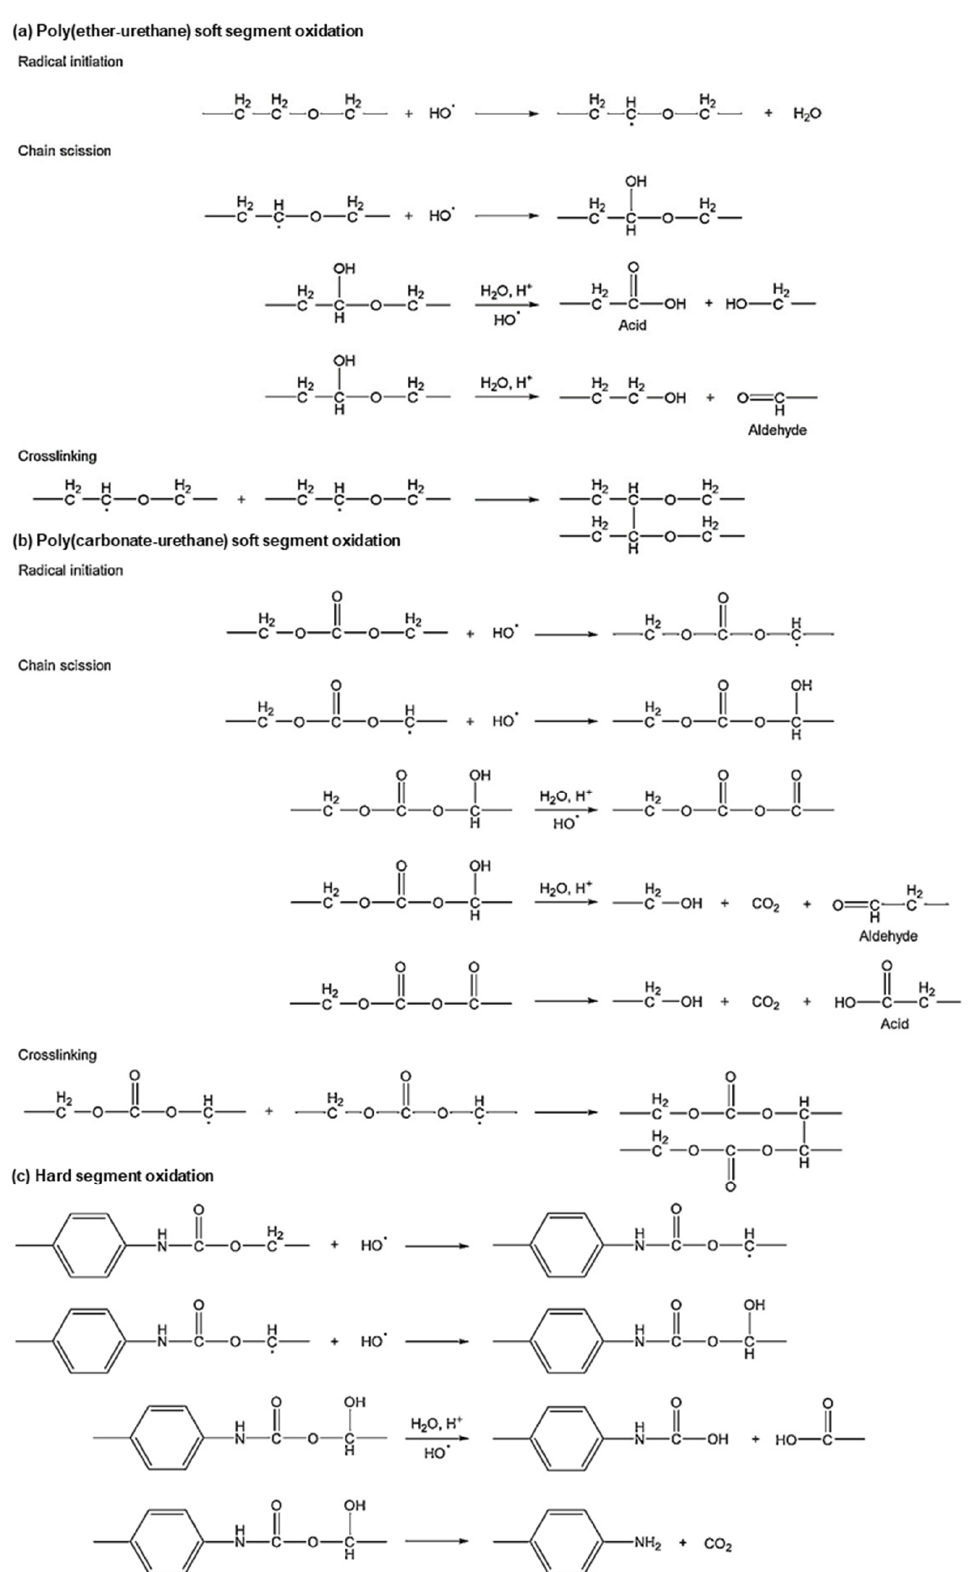
Figure 5. Oxidation of poly(ether-urethane)s and poly(carbonate-urethane)s (adapted with permission [77] ©2018, Elsevier B.V.).